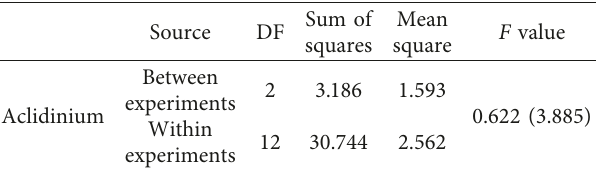
The values between parentheses are the theoretical F values; the population means are not significantly